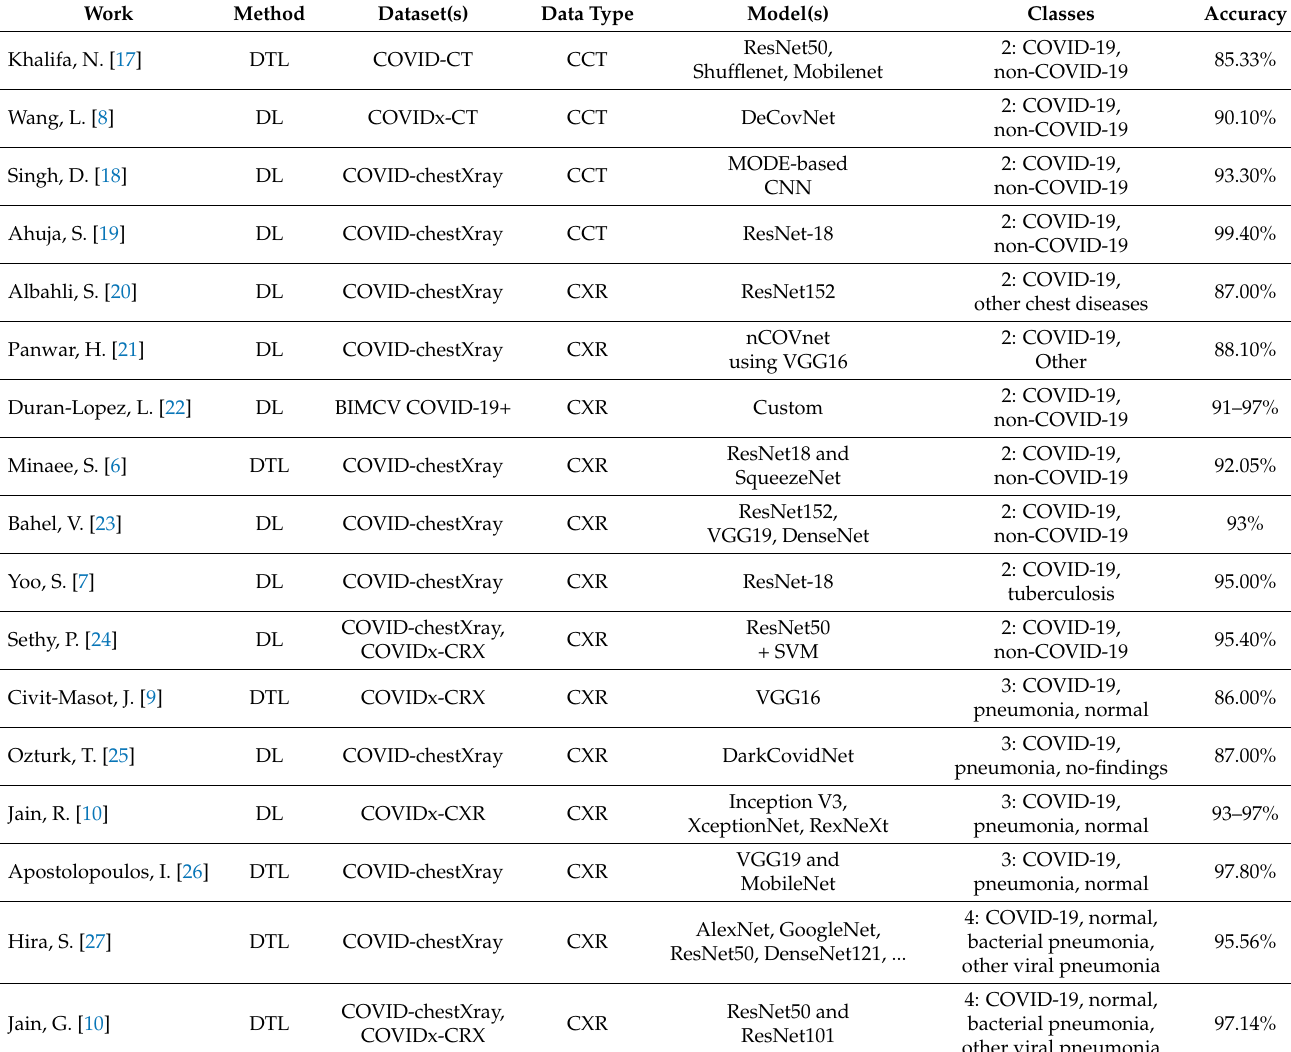
Table 2. Deep Learning based CXR and CCT COVID-19 classification